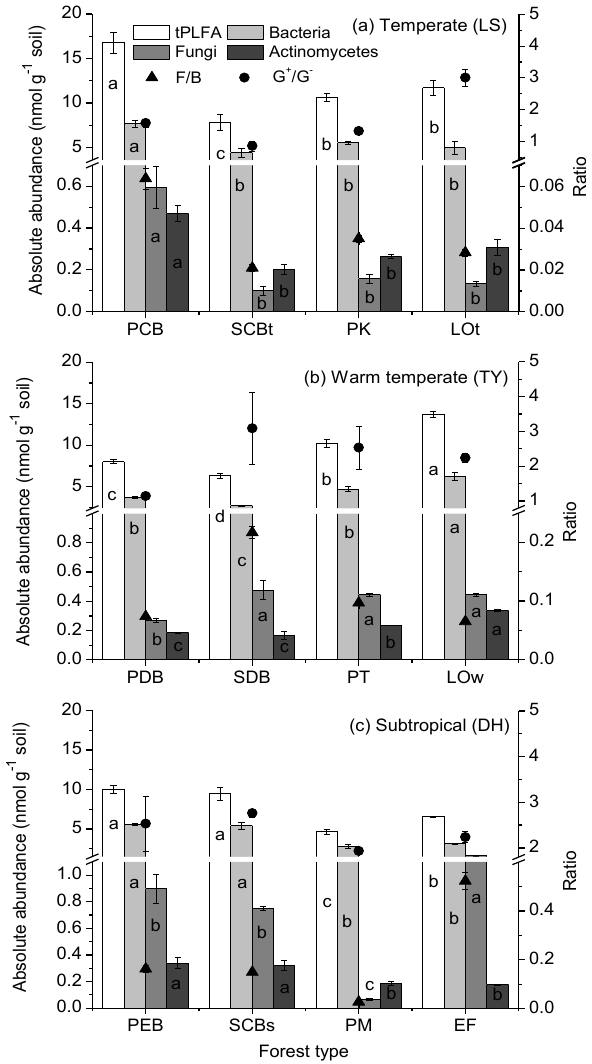
Figure 2. The PLFA contents, fungi / bacteria ratios, and G + /G − for different forest types in different climatic zones ( a Liangshui; b Taiyue; c Dinghu). Different lowercase letters indicate signifi- cant differences among forests in the same climatic zone. F / B – fungi / bacteria; G + /G − – gram-positive bacteria/gram-negative bacteria. The abbreviations of the sampling sites are shown in Ta- ble